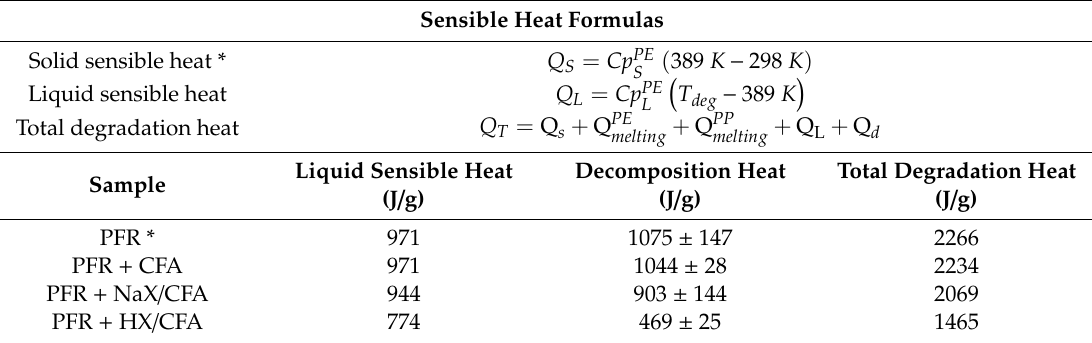
Table 1. Liquid sensible, decomposition, and total degradation heats of PFR during thermal and catalytic degradation (CFA, NaX / CFA, HX / CFA). Solid sensible and fusion heats remain unchanged during catalytic